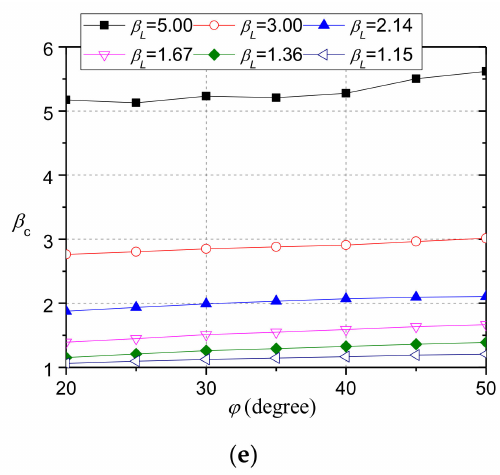
Figure 17. Results of the parametric study: ( a ) u ; ( b ) v ; ( c ) f b0 / f c0 ; ( d ) K c ; ( e ) ϕ .